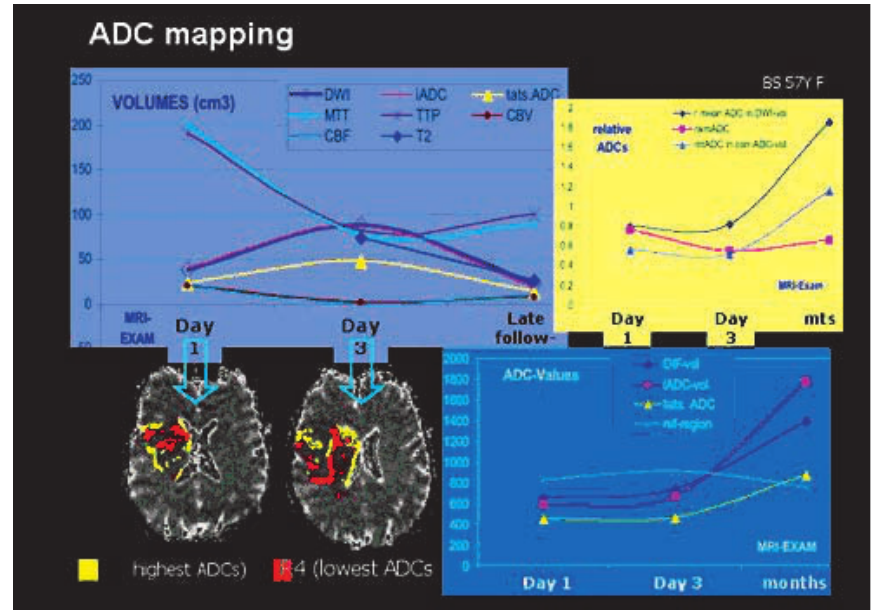
ADC mapping of the penumbra: in the penumbra there are onion-shaped areas of different ADC val- ues with increasing values from the cen- tre of the lesion to- wards the